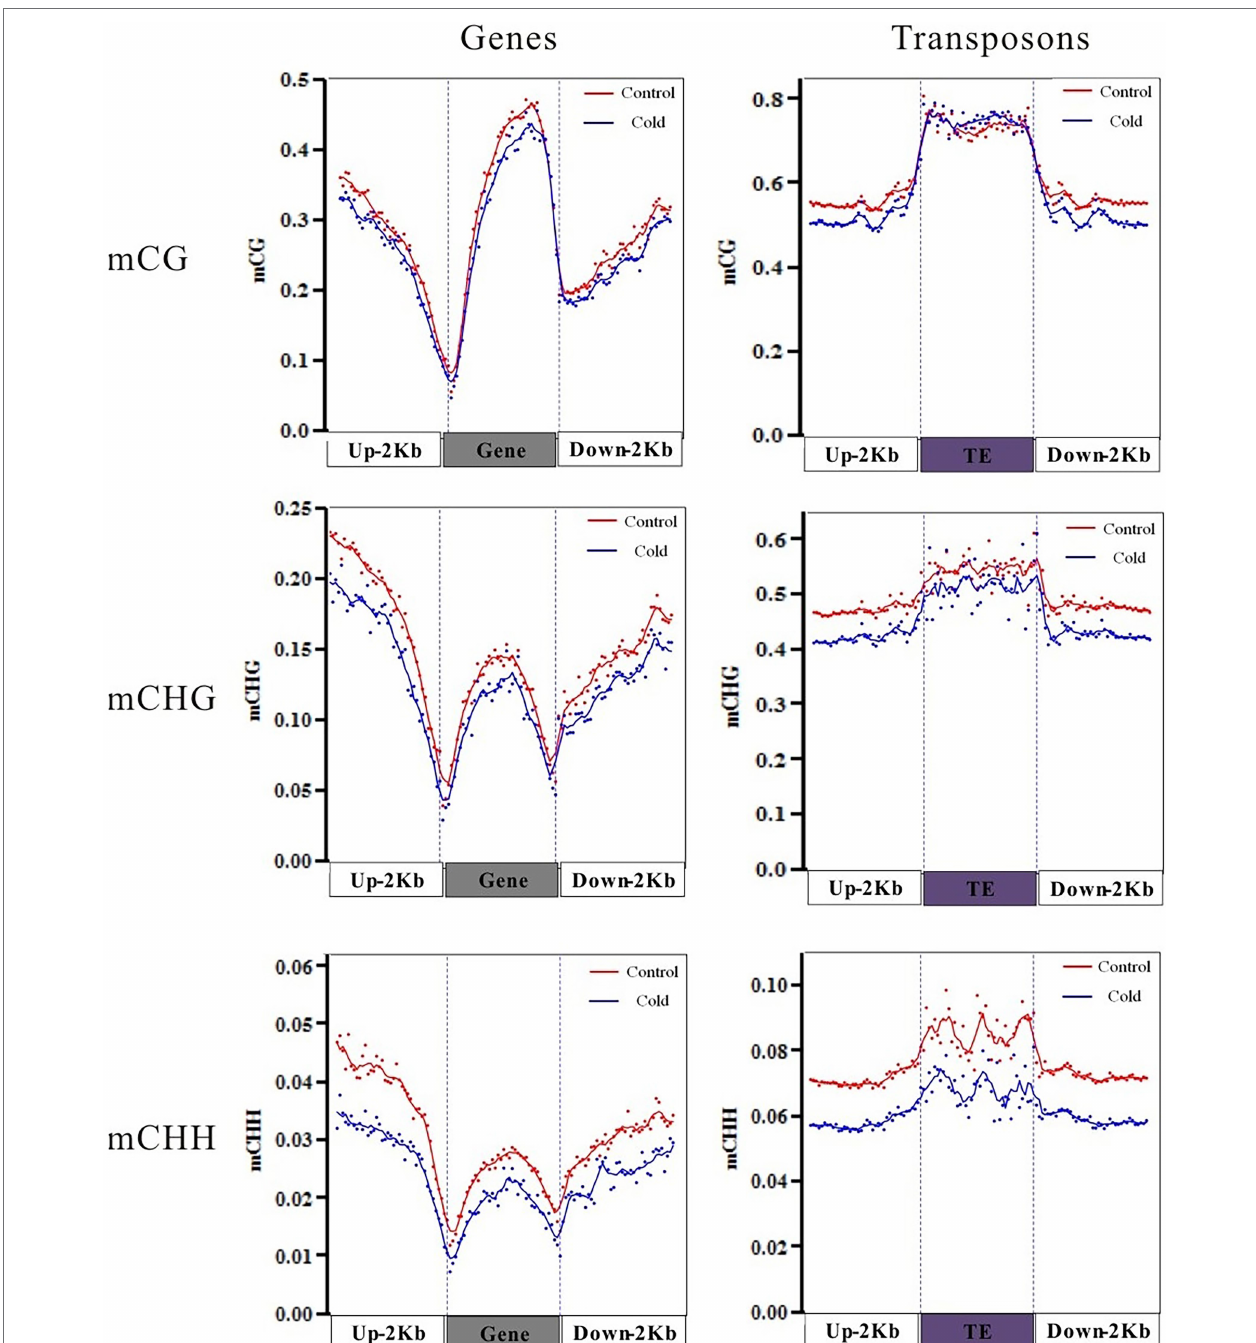
FIGURE 2 | Methylation patterns of genic and transposon element (TE) regions after cold treatment. Levels of mC, mCG, mCHG, and mCHH methylation distributed in the gene body, upstream region, and downstream region of genes and TEs. 2-kb region upstream of the transcription start site; gene body; downstream, the 2-kb region downstream of the transcription termination